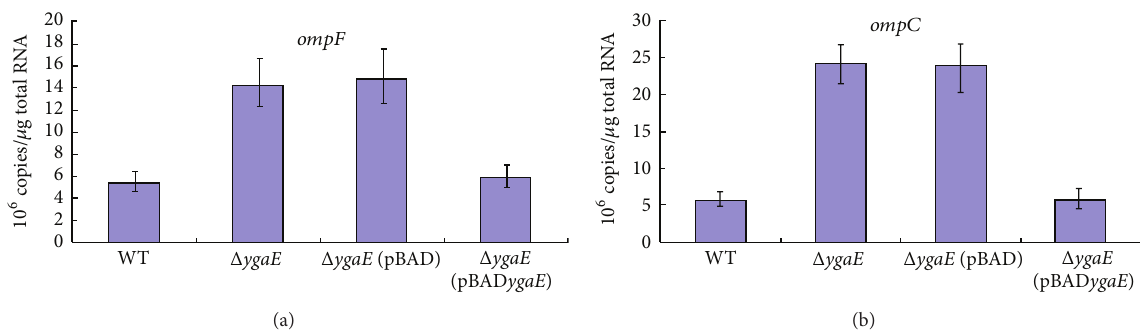
Figure 2: qRT-PCR was performed to detect expression of out membrane proteins in wild-type strain(WT), Δ ygaE, Δ ygaE (pBAD), and Δ ygaE (pBAD ygaE ) strains in hyperosmotic LB medium. Data are the mean ± SD from three independent experiments. (a) Expression of ompF in the Δ ygaE strain was increased threefold, compared to the wild-type strain. The complementation of ygaE to Δ ygaE strain repressed the expression of ompF to wild-type strain level. The expression of ompF in Δ ygaE (pBAD) was similar to Δ ygaE strain. (b) Expression of ompC in the Δ ygaE strain was increased fourfold, compared to the wild-type strain. The complementation of ygaE to Δ ygaE strain repressed the expression of ompC to wild-type strain level. The expression of ompC in Δ ygaE (pBAD) was similar to Δ ygaE strain.